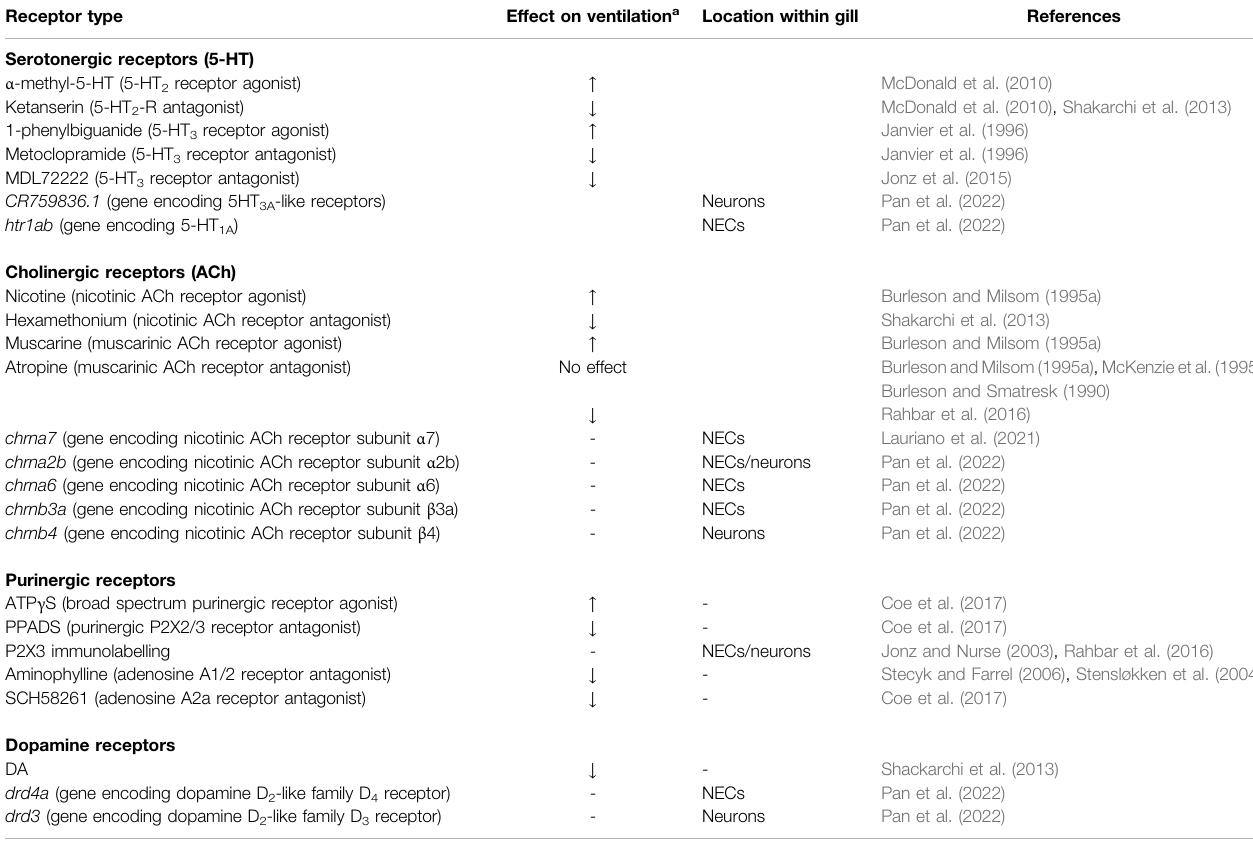
TABLE 1 | Summary of receptor types reported to effect changes in ventilation amplitude and/or frequency and their location within the gill, if available. The fi rst column indicates receptor type, as characterized by pharmacological studies, gene expression analysis or immunohistochemistry. Receptor